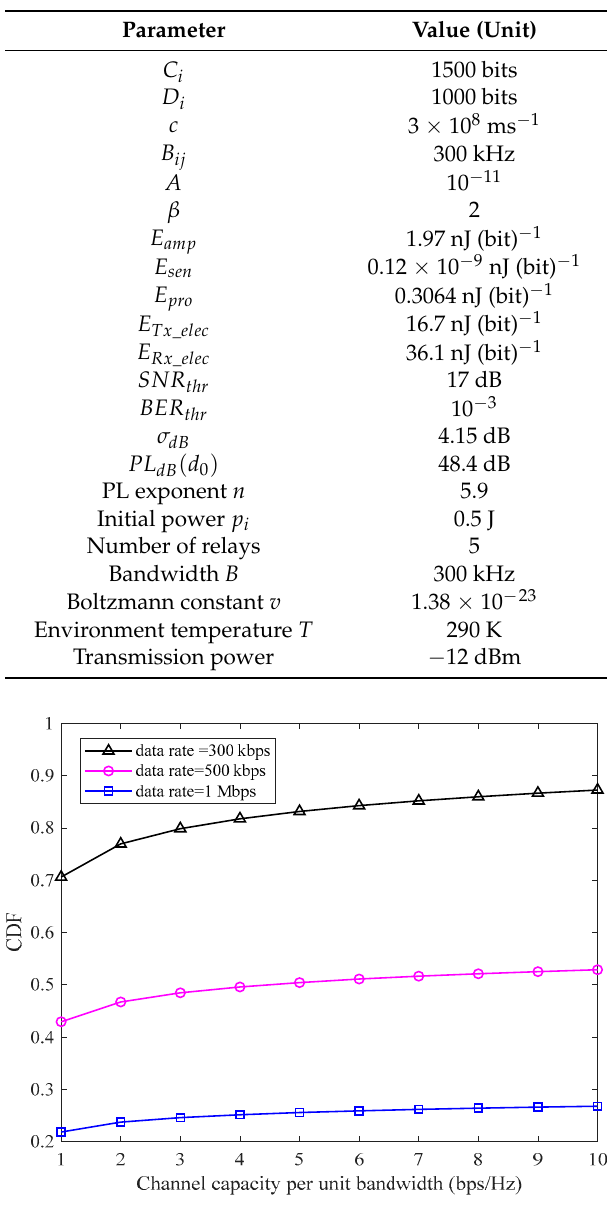
Figure 3. Link quality versus transmission distance under different rates.